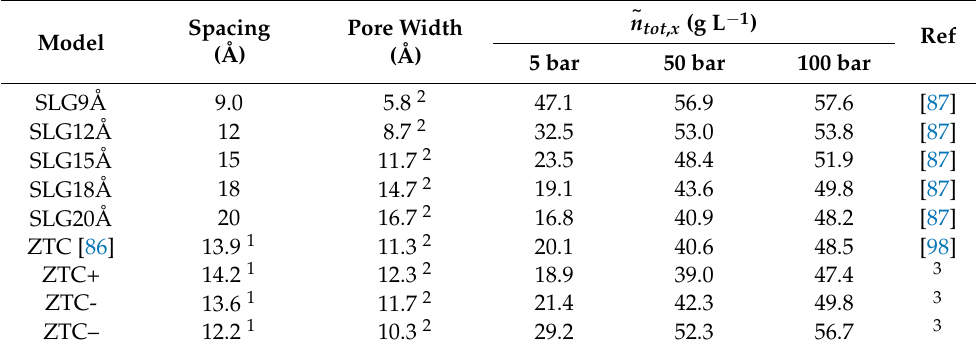
Figure 4. Trends in volumetric H 2 storage and delivery on idealized (crystalline) porous carbon models at 77 K. ( a ) Excess H 2 uptake on ZTC powder compared to a series of single-layer graphene (SLG) slit pore models. The crystalline assumption is employed for ZTC using a periodic model [86]. ( b , c ) Total H 2 uptake and delivery on ZTC and SLGs under the crystalline assumption. ( d ) Periodic model of ZTC and calculated structural parameters (2.4 Å diameter probe). ( e , f ) Total H 2 uptake and delivery on ZTC and three expanded/contracted models of ZTC: 22% expanded (ZTC+), 22% contracted (ZTC-), and 69% contracted (ZTC--), all under the crystalline assumption. Excess H 2 adsorption data were obtained from the following references: ZTC [98] and SLG slit pore models [87] (see Supplementary Materials). Table 3. Volumetric H 2 storage calculations on idealized (crystalline) porous carbon models at 77 K (as shown in Figure